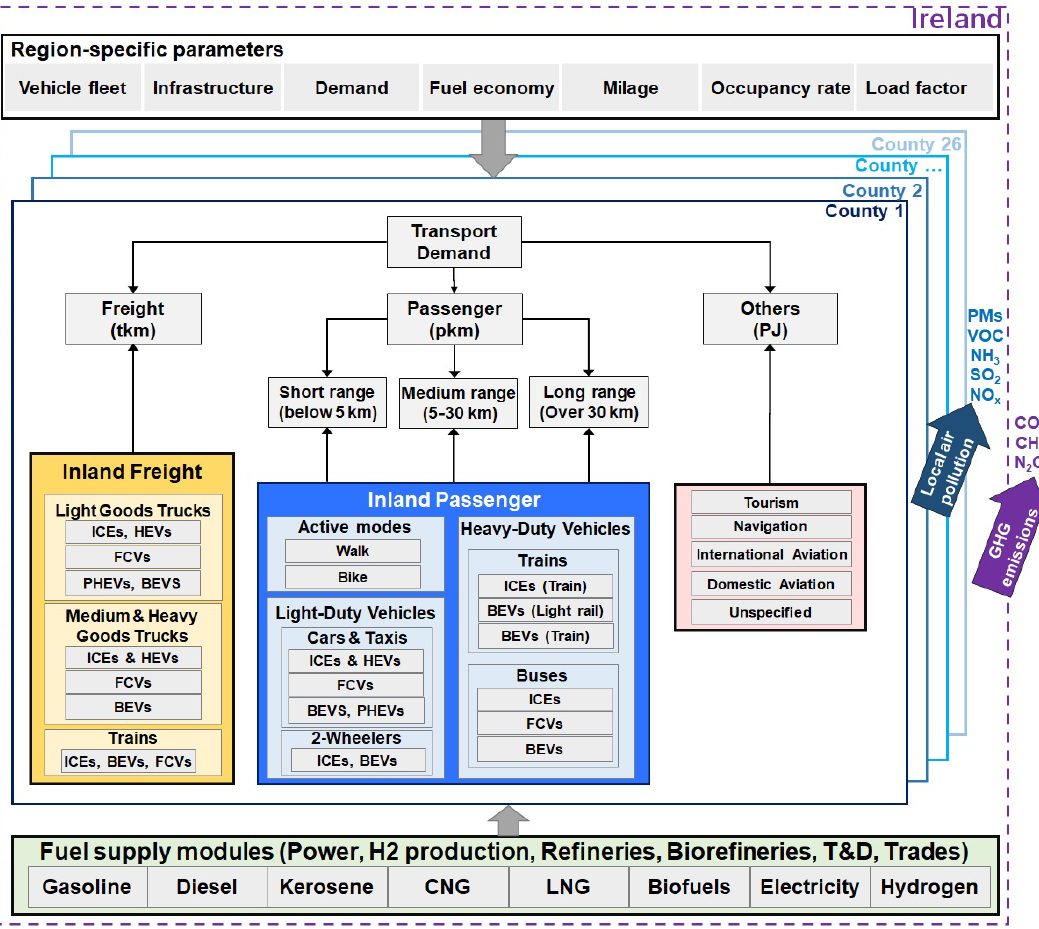
Figure 4. Transport structure in